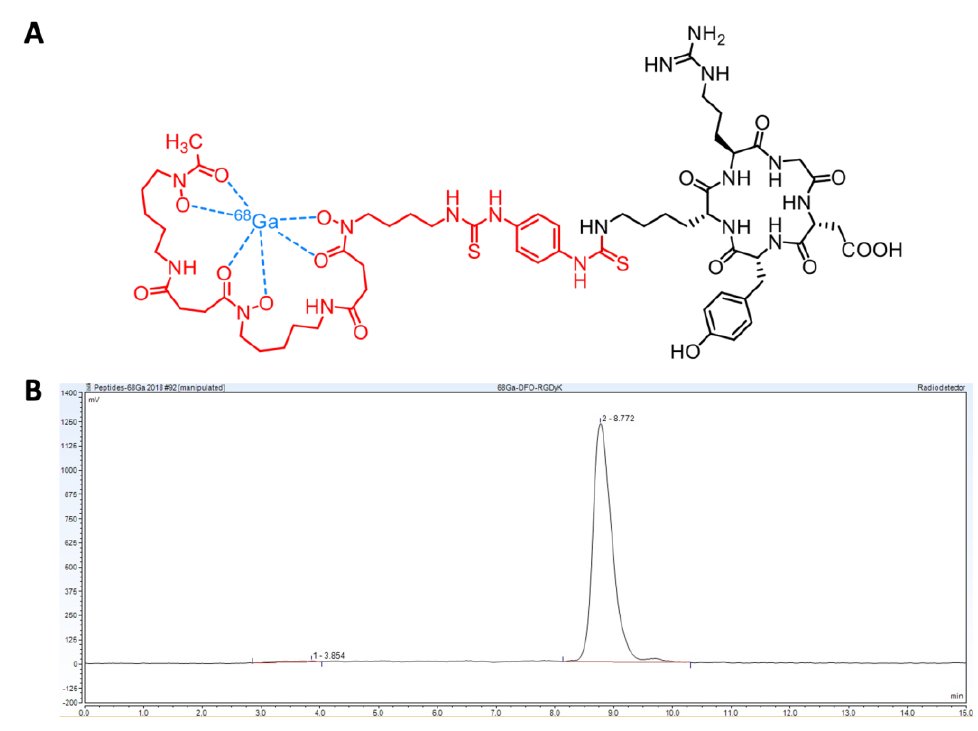
Figure 1. [ 68 Ga]Ga-DFO-c(RGDyK) structure ( A ) and representative radiochromatogram ( B ). Table 1. In vitro characterization of [ 68 Ga]Ga-DFO-c(RGDyK). Log P, protein binding (expressed as % of protein bound activity of the total activity used) and stability in human serum, PBS, 0.1 M FeCl 3 , and 6 mM DTPA. Log P (n =